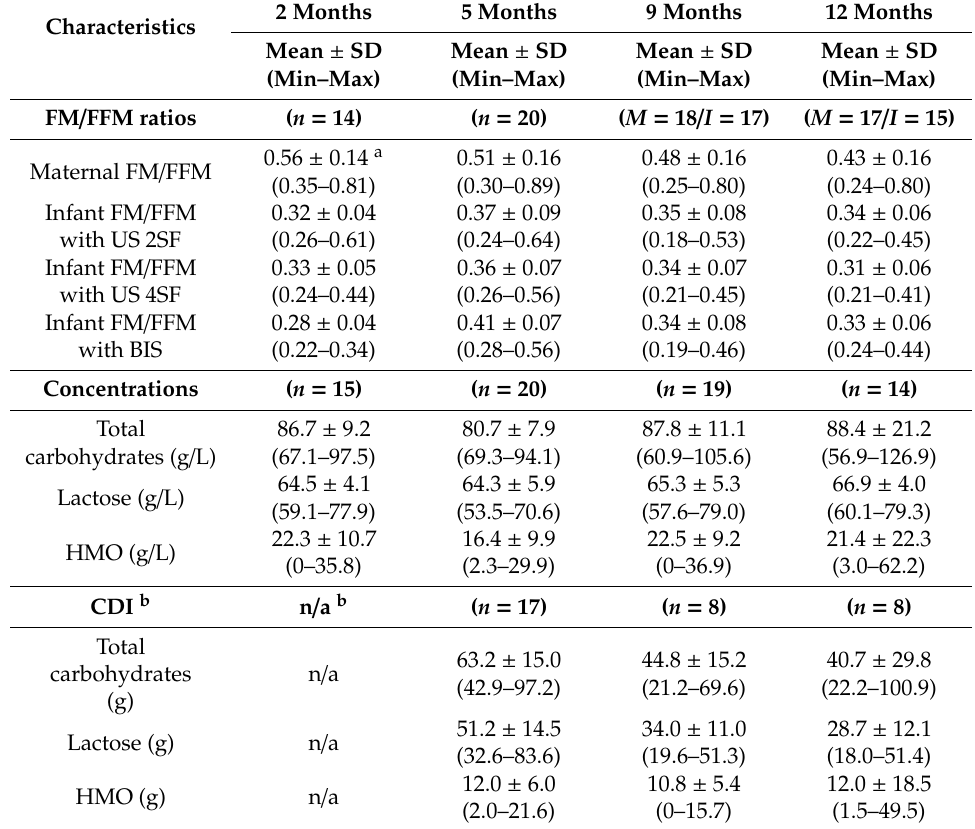
Table 1. Fat mass to fat-free mass ratios and concentrations and 24-h intakes of human milk carbohydrates during first 12 months of